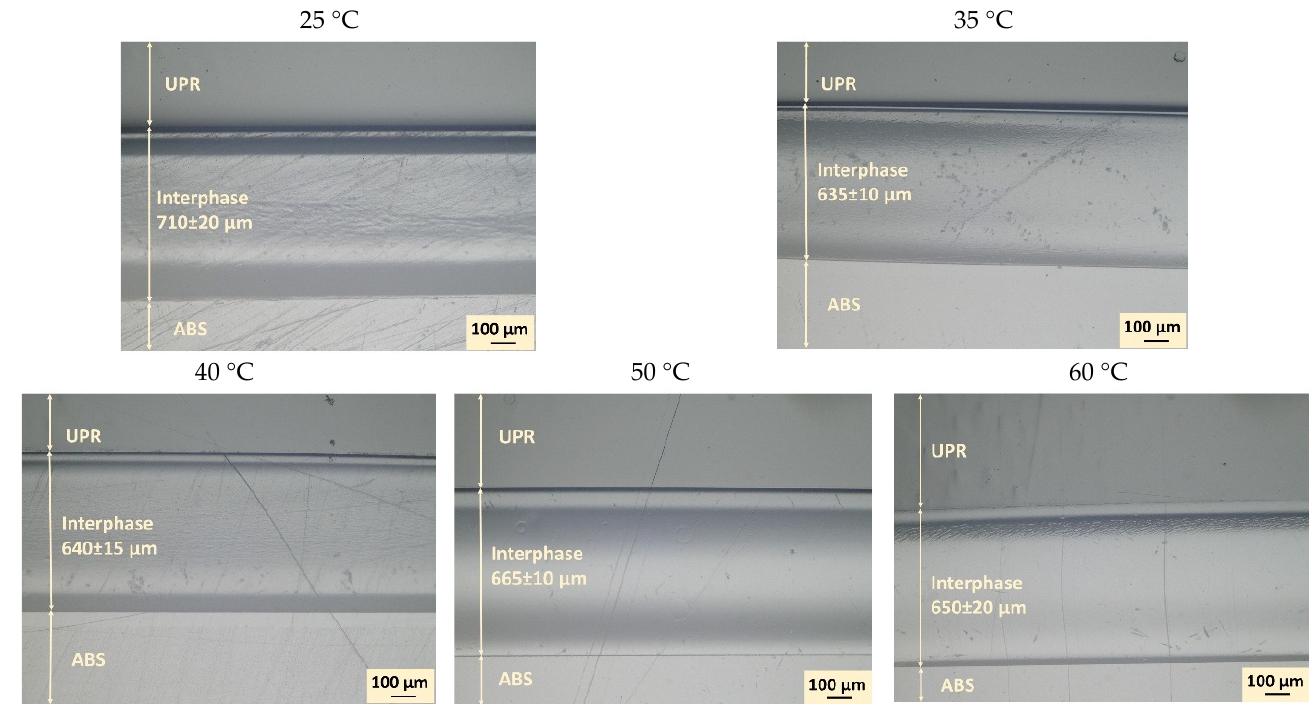
Figure 5. Micrographs showing the interphase formation between ABS and UPR at different temperatures.